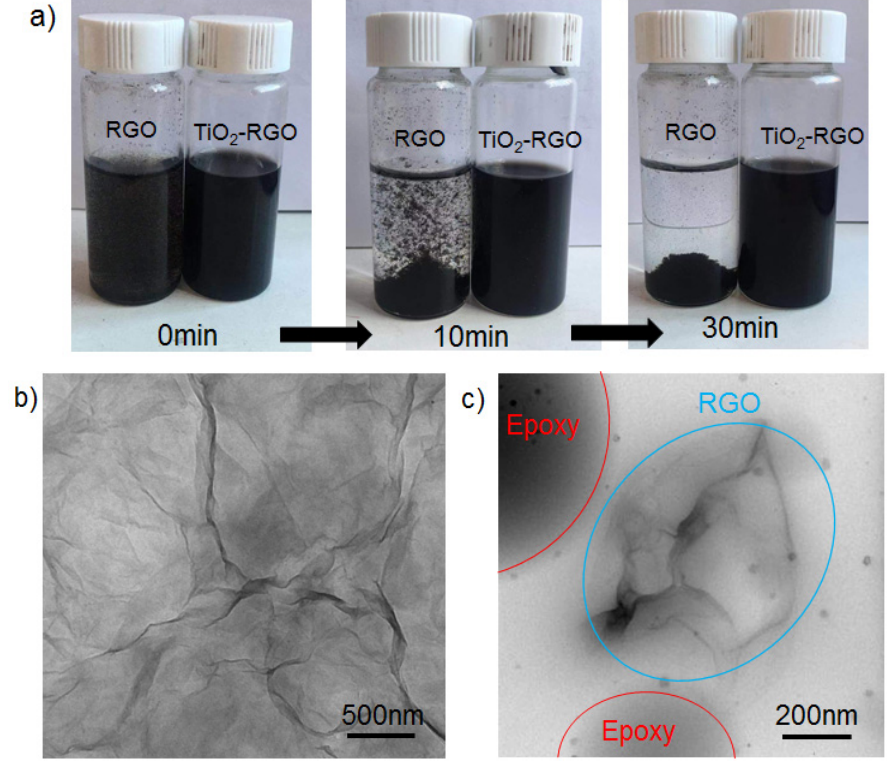
Figure 5. The macro- and micro-morphologies and disperse states of RGO, TiO 2 -RGO and TiO 2 - RGO-EP. ( a ) Macroscopic observation of disperse state; ( b ) TEM image TiO 2 -RGO nanoparticles; ( c ) TEM image of TiO 2 -RGO-EP composites.